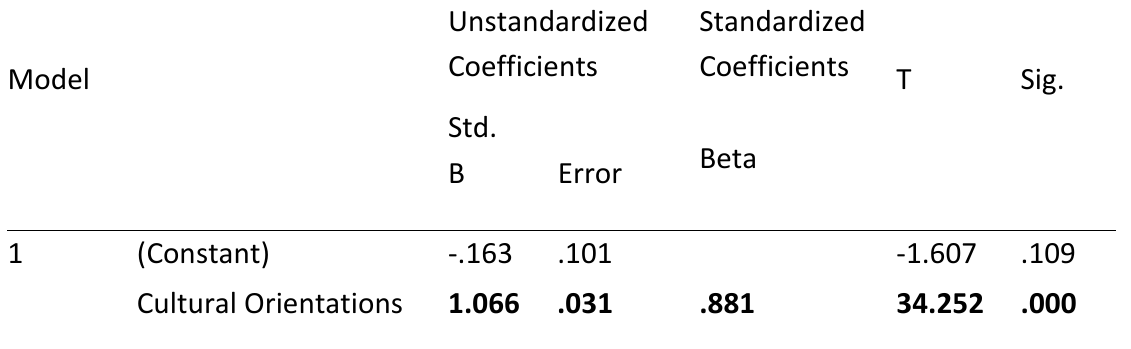
Table 12. Regression coefficient